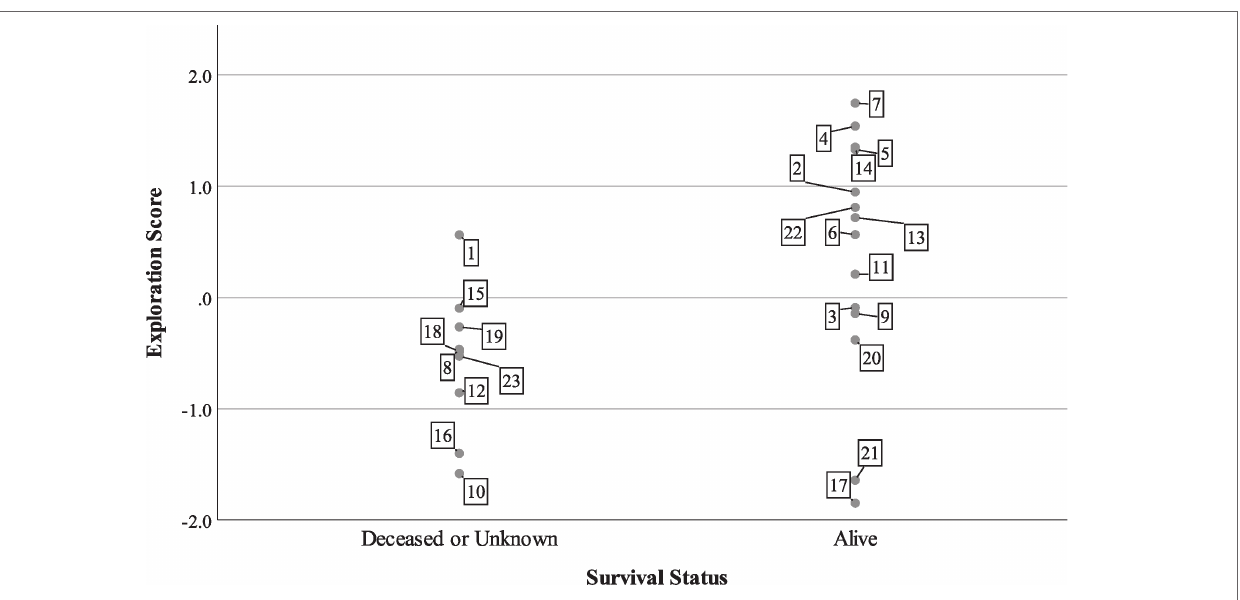
FIGURE 3 | Survival status of n = 23 Blanding’s turtles 2 years after reintroduction compared to exploration factor scores. Cases are labeled by turtle